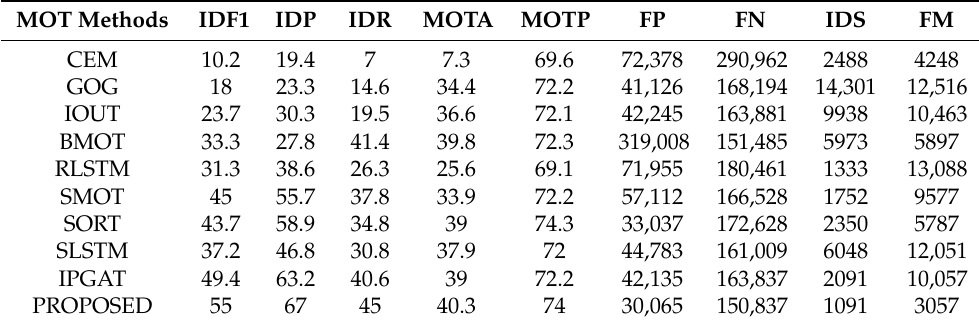
Table 1. The detection input of the faster RCNN. MOT: multiple object tracking; IDP: identification precision; IDR: identification recall. MOTA: multiple object tracking accuracy. MOTP: multiple object tracking precision. FP: false positive. FN: false negative. IDS: identification switches, and the total number of times a trajectory is fragmented (FM).